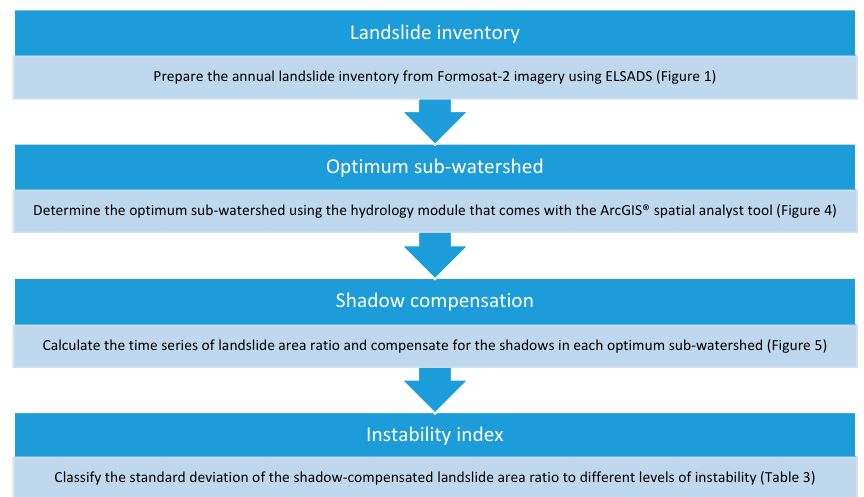
Figure 6. All of the thumbnails of cloudless images selected to prepare the annual landslide inventory in the watershed of a potential debris flow torrent Tainan DF045.